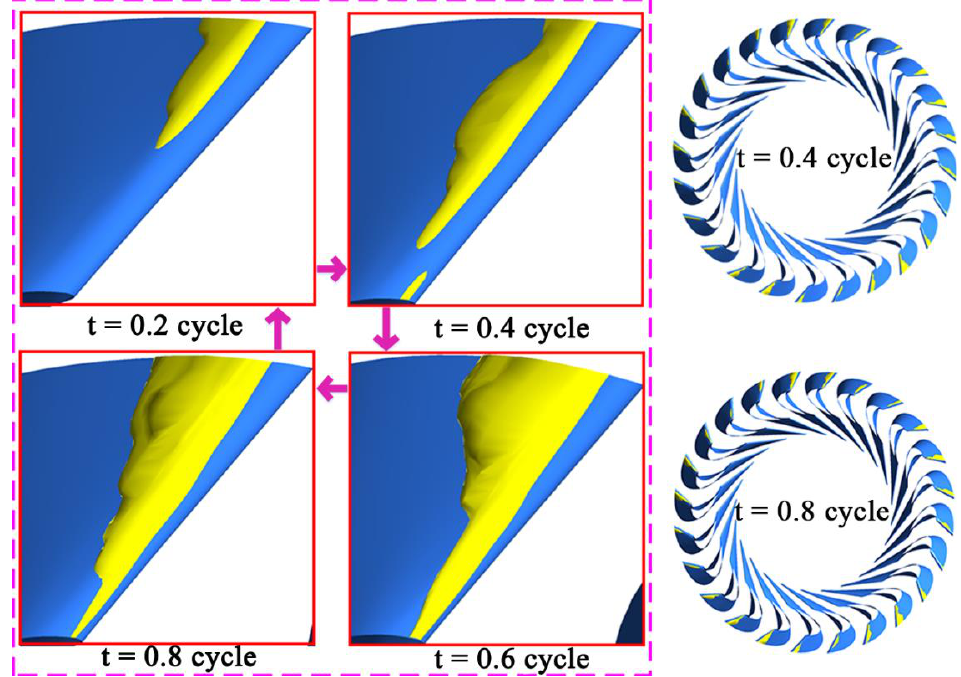
Figure 6. Evolution of 10% vapor volume fraction distribution in turbine domain under stall operating condition.